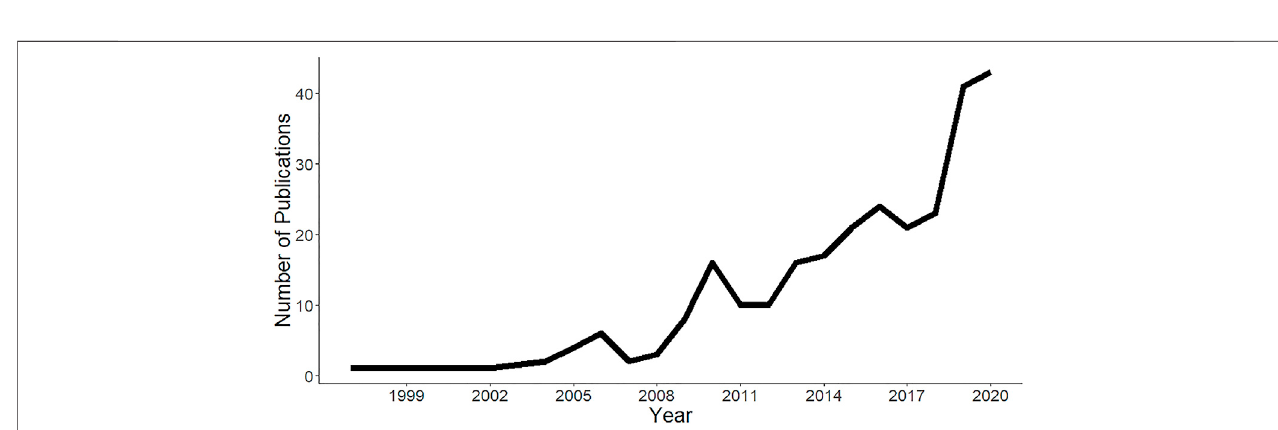
FIGURE 2 | Number of publications in collection ( n (cid:1) 272) by year (1997 –